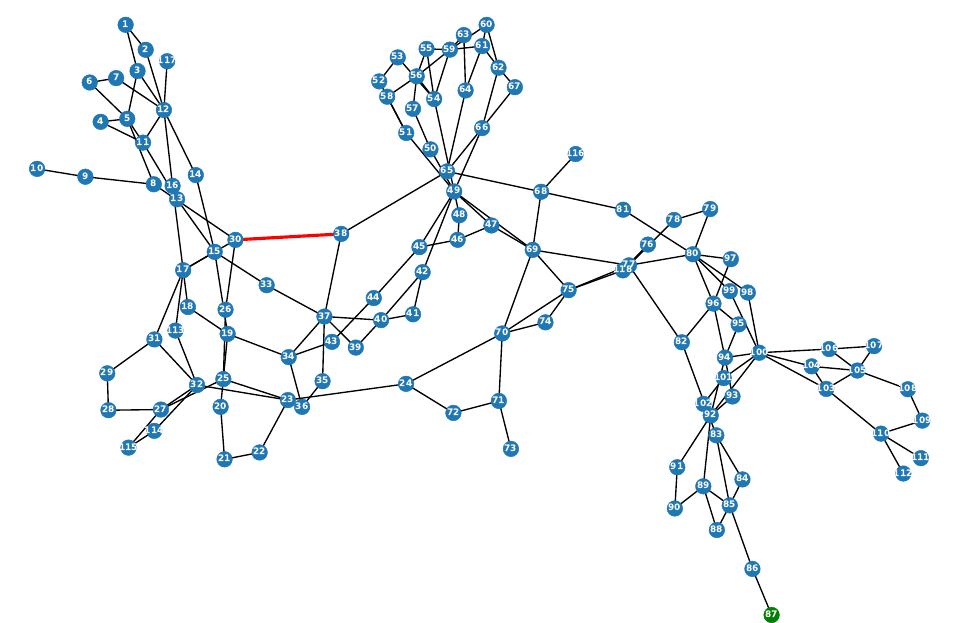
Figure 9. The optimal 1 × 150 MW demand and mobile MSSSC allocation during seasons 1 and 3. Red lines indicate the mobile MSSSC deployment locations; green node indicates the load connection location. Table 3. Mobile MSSSC allocation simulation results with 1 × 150 MW